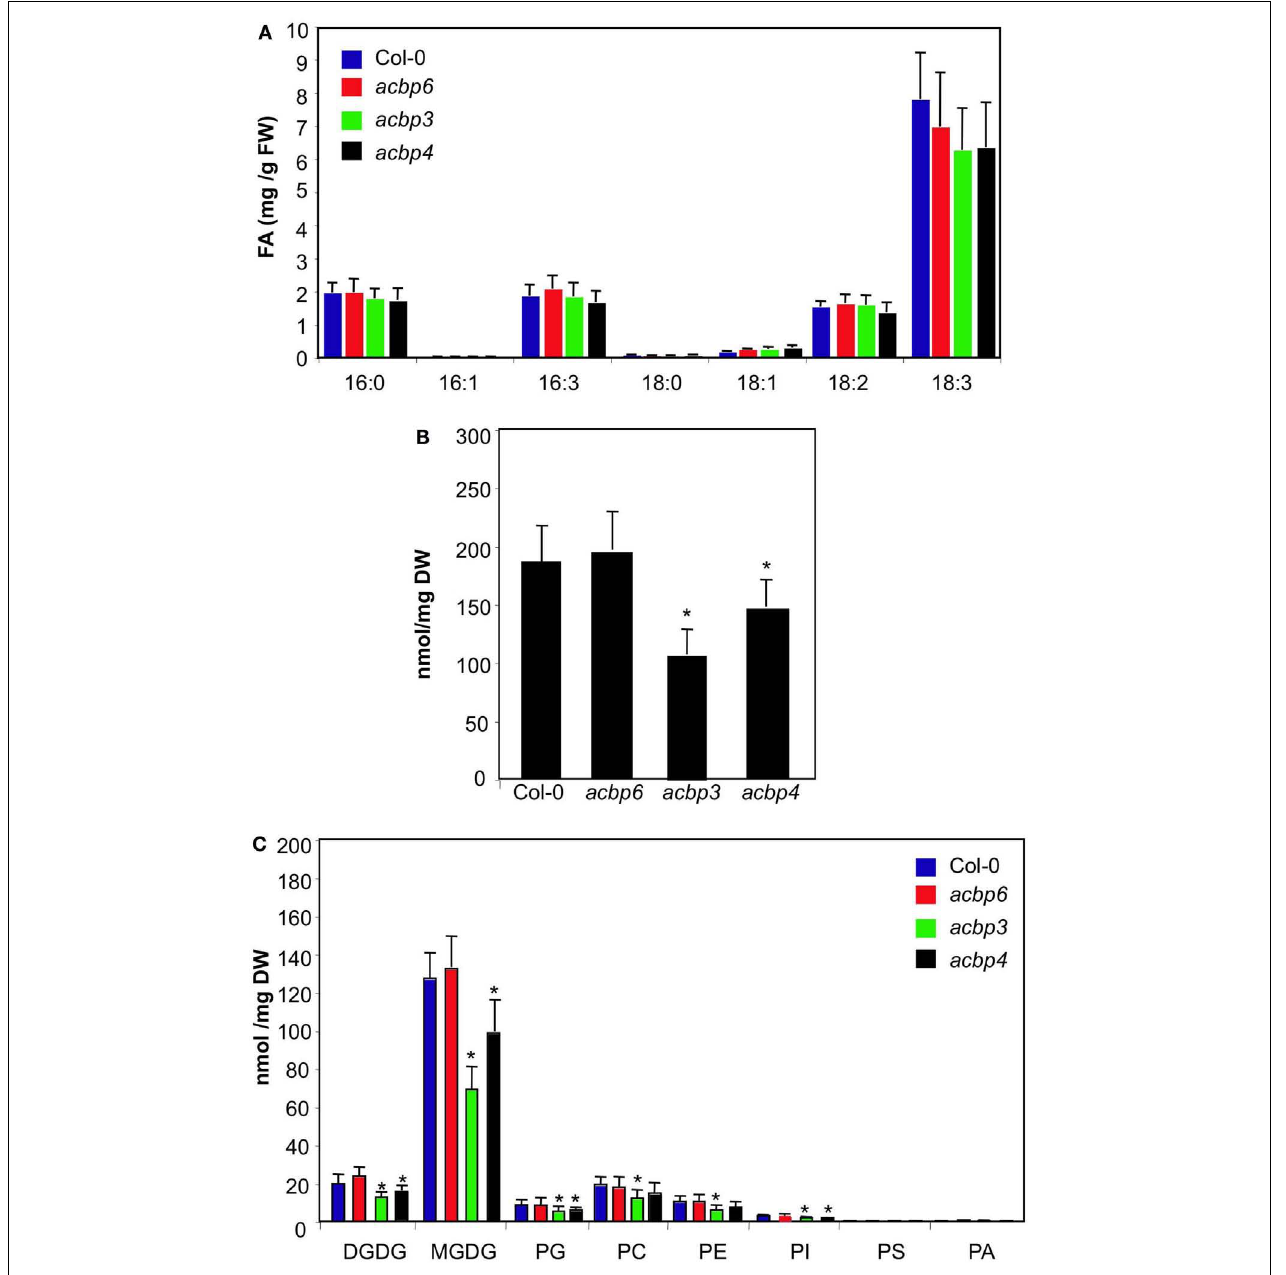
total lipids extracted from Col-0 and acbp mutant plants.The values are presented as a mean of five replicates.The error bars represent SD. Asterisks denote a significant difference with Col-0 ( t- test, P < 0.05). Symbols for various components are: DGD, digalactosyldiacylglycerol; MGD, monogalactosyldiacylglycerol; PG, phosphatidylglycerol; PC, phosphatidylcholine; PE, phosphatidylethanolamine; PI, phosphatidylinositol; PS, phosphatidylserine; PA, phosphatidic